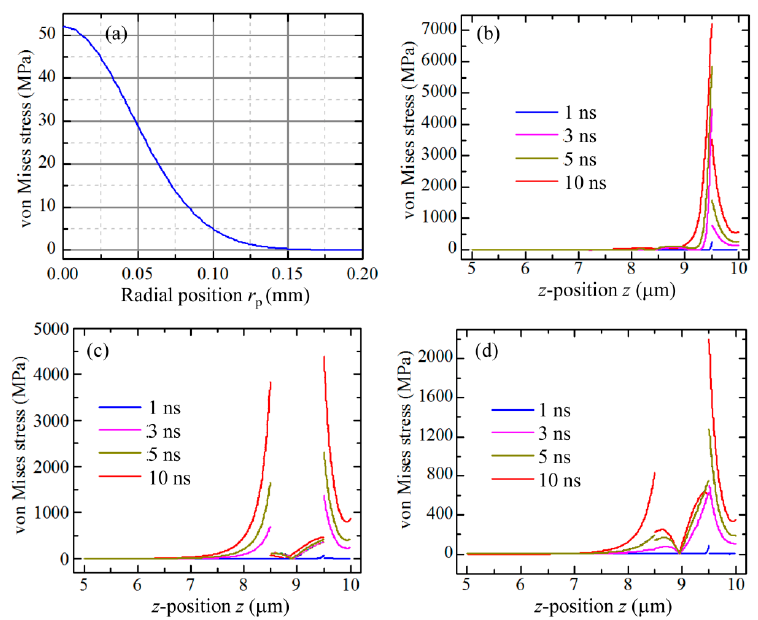
Figure 8. Comparison of the von Mises thermal stress distributions with and without impurity defects. ( a ) Thermal stress distribution along the radial direction ( z = 10 μ m) on fused silica surface without impurity defect. The maximum stress at r p = 0 μ m could be applied in the comparison with those caused by the impurity defects. The von Mises thermal stress distribution along the central axis ( r p = 0 μ m) caused by ( b ) CeO 2 ; ( c ) Al and ( d ) Fe defects for various laser loading times. The z -positions of 8.5 μ m and 9.5 μ m are the intersection points of fused silica with the downmost and upmost parts of the impurity defect.